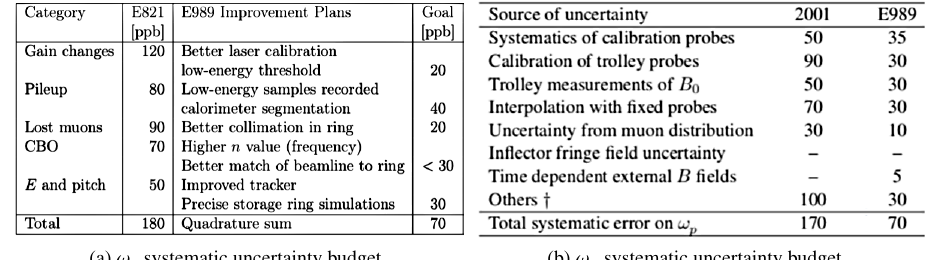
Figure 2: The design systemic uncertainty goals of the measurements of ω a and ω p compared the final systematic uncertainty estimate from the BNL experiment [5]. All values are given in